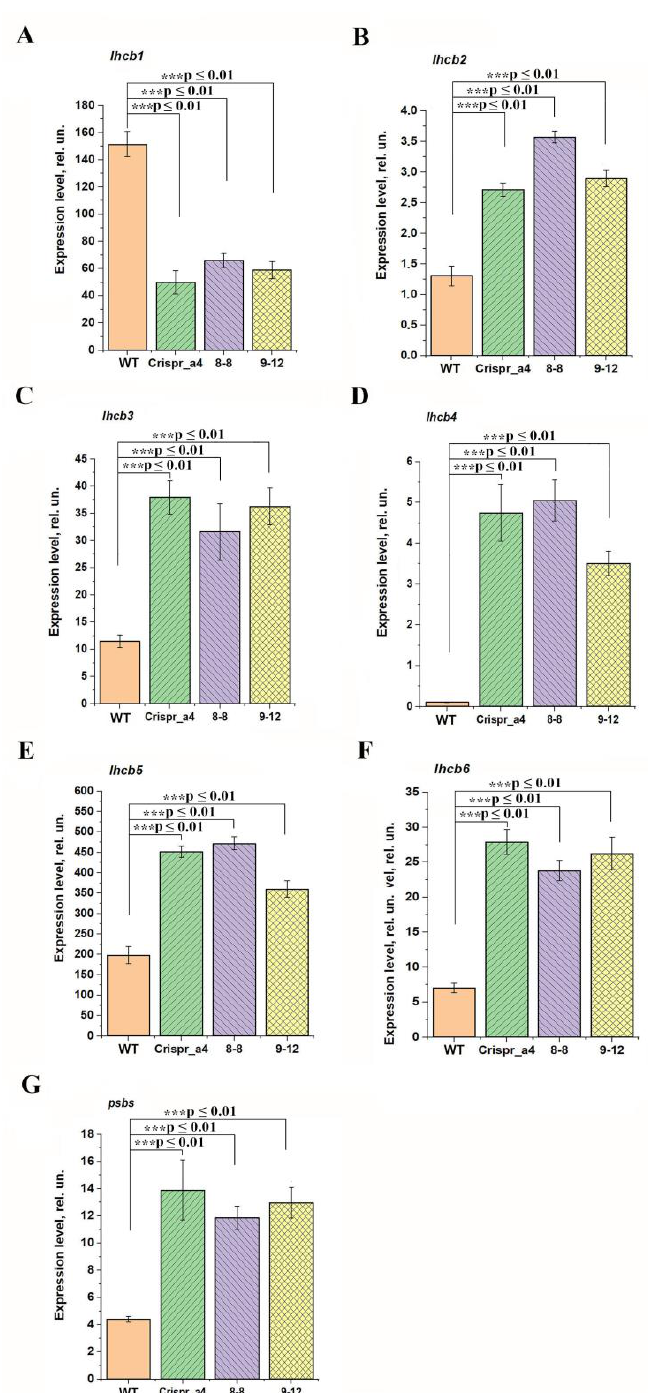
Figure 6. The expression level of lhcb1 ( A ), lhcb2.2 ( B ), lhcb3 ( C ), lhcb4 ( D ), lhcb5 ( E ), lhcb6 ( F ) and psbs ( G ) genes in leaves of Arabidopsis WT plants and α CA4-KO lines: Crispr_ α 4, 8-8 and 9-12. Data were normalized for actin gene expression. Data are shown as mean ± the SE (n = 3). The experiments were performed three times with similar results. Significant differences were denoted as *** p ≤ 0.01.